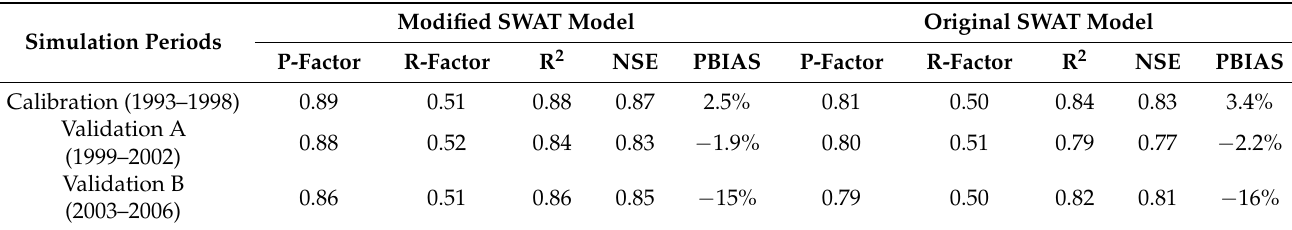
Table 5. Performance summary of original and modified SWAT models in calibration and validation periods. Simulation